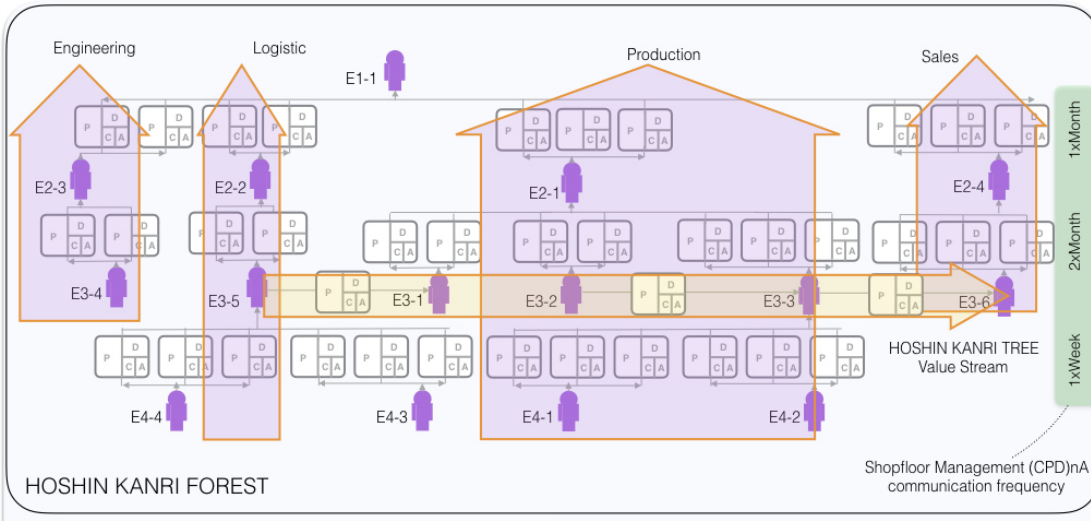
Figure 4. Part of the HOSHIN KANRI FOREST STRUCTURE